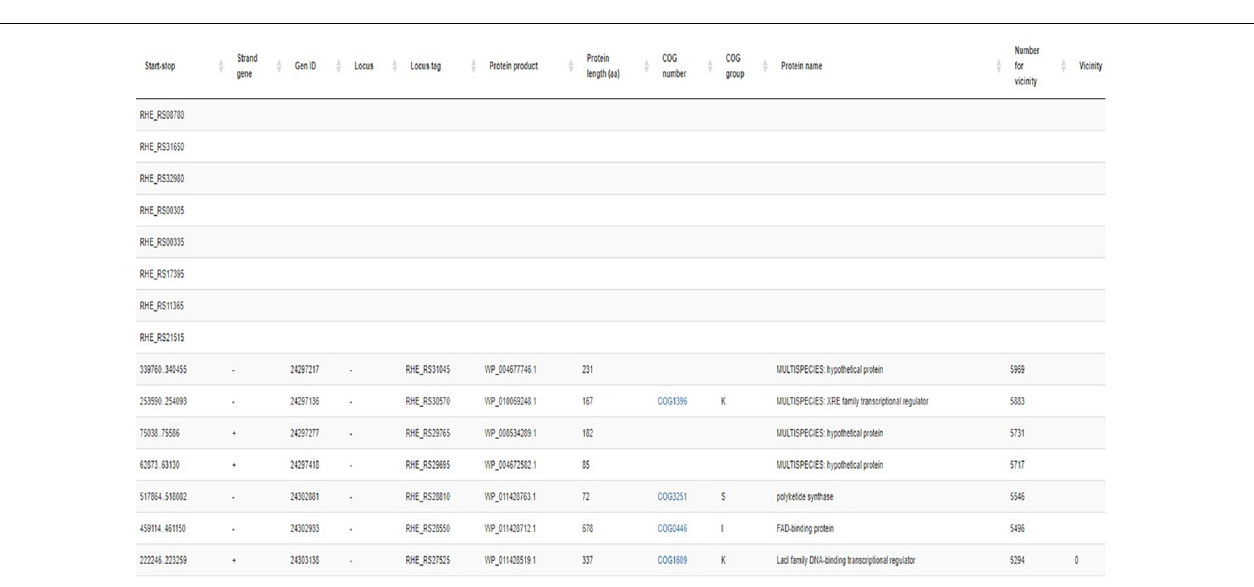
FIGURE 2 | Gene information window for the gene RHE_RS00185 from R. etli